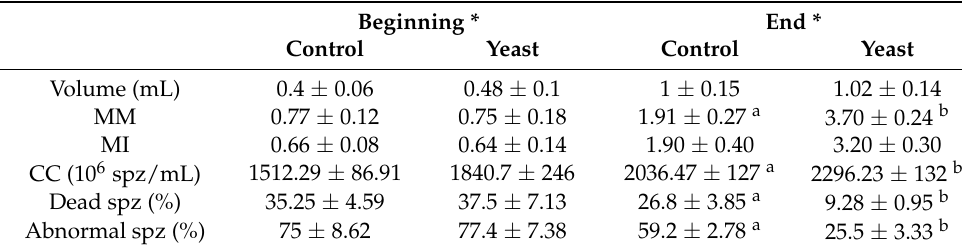
Table 3. Sperm quality traits of control and yeast-treated Queue Fine de l’Ouest rams (means ±